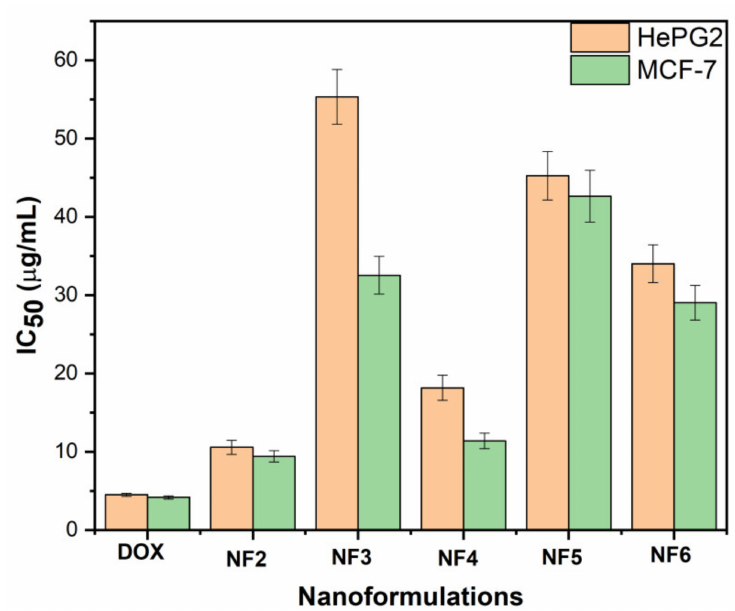
Figure 7. The calculated concentrations of IC 50 for nanofibrous scaffolds (NF1–NF6); IC 50 ( µ g / mL): 1–10 (very strong); 11–20 (strong); 21–50 (moderate); 1–100 (weak); above 100 (non-cytotoxic).DOX: